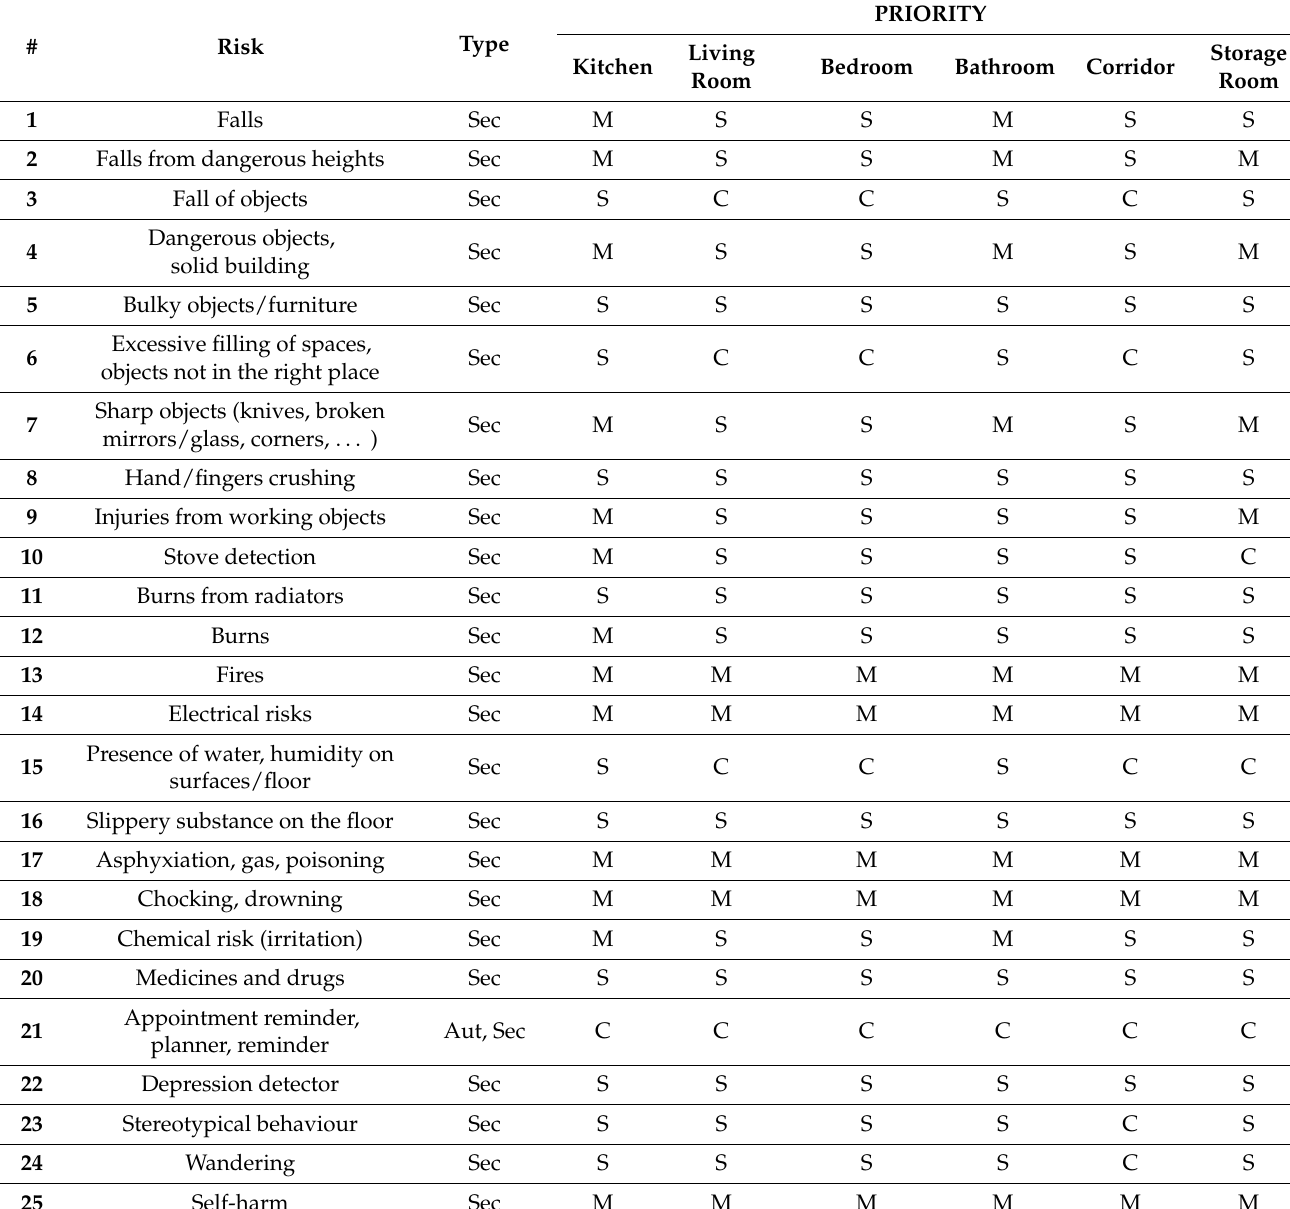
Table A2. Priority MoSCoW scale associated with the accidental